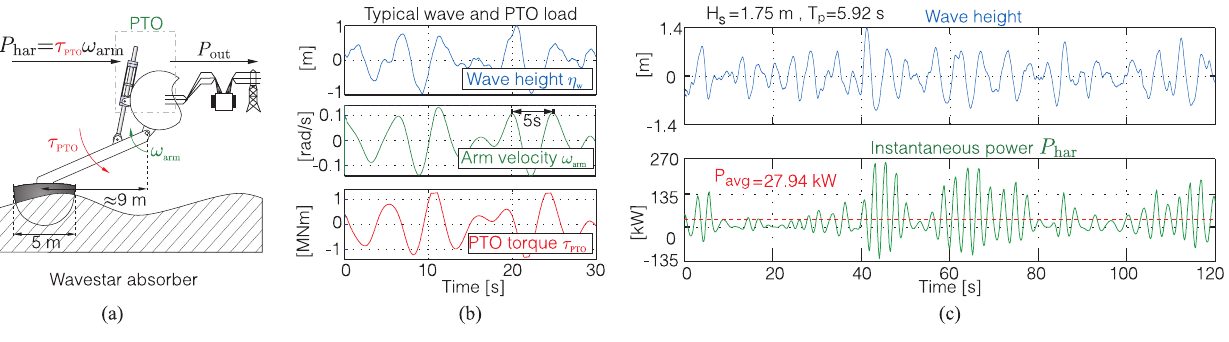
Figure 2. ( a ) a Wavestar absorber; ( b ) velocities and PTO load in typical production waves; and ( c ), instantaneous power during two minutes production for a single absorber.